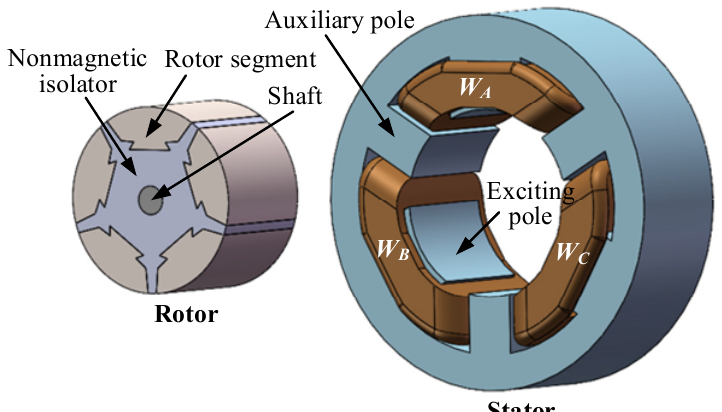
Figure 3. Diagram of traditional 12/8 SRM structure.